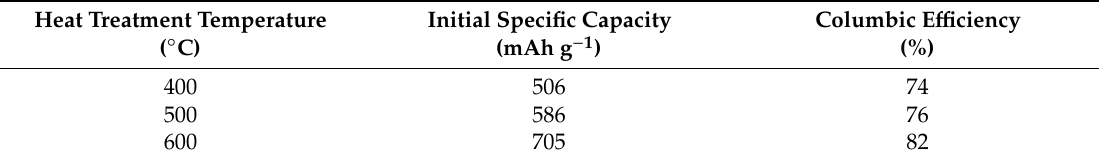
Table 3. Initial specific capacity of the SiO 2 / C composite depending on the heat treatment temperature.